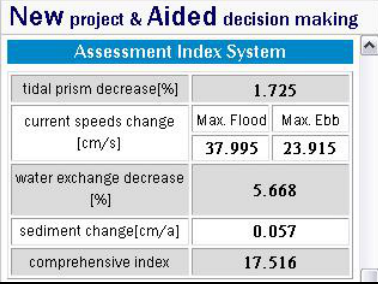
Figure 8. Coastal environmental impact assessment results displayed on the webpage.